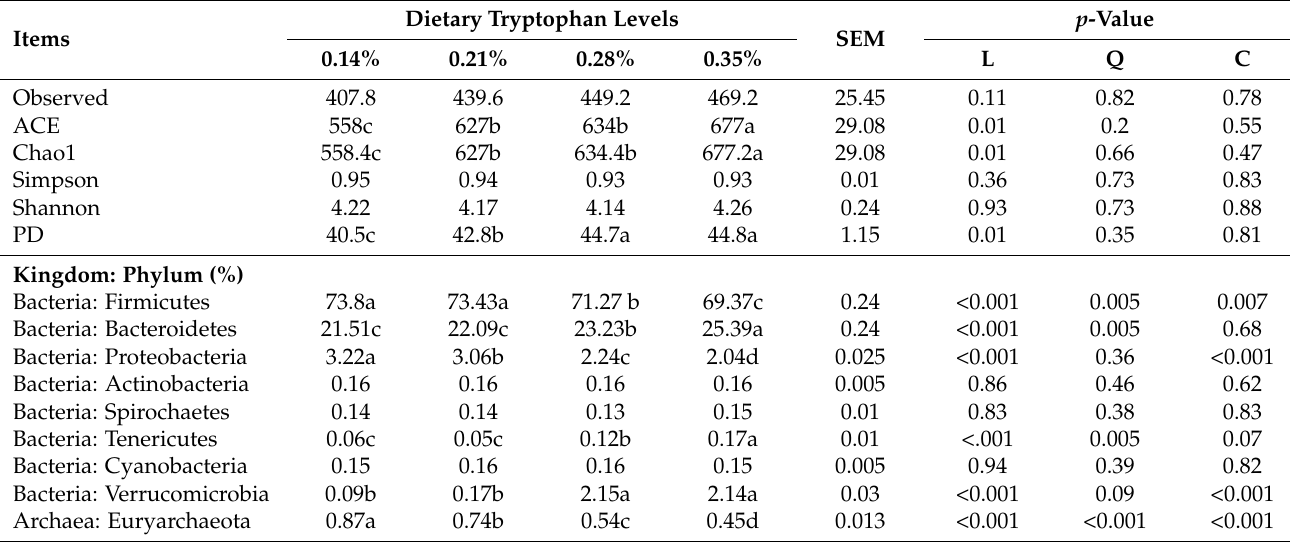
Table 8. Effect of dietary tryptophan levels on coverage estimator (ACE), Chao1, Shannon, Simpson, and PD diversity indices and the microbial composition at the phylum level in the caecum microbiota of weaned piglets.